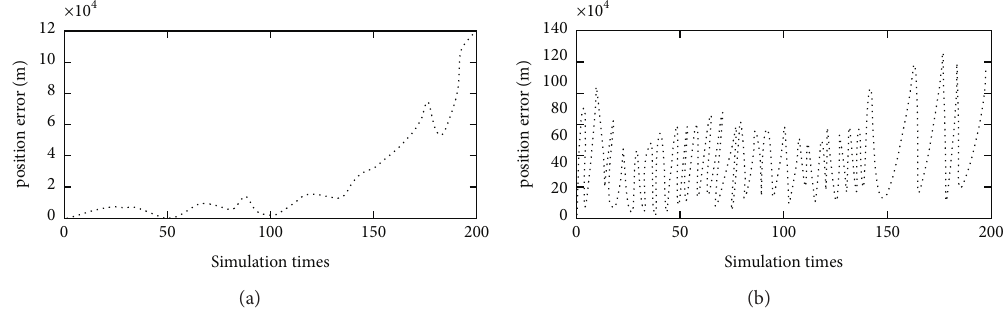
Figure 3: Position error simulation results of two algorithms. (a) Conventional Kalman filter. (b) Strong tracking Kalman filter.